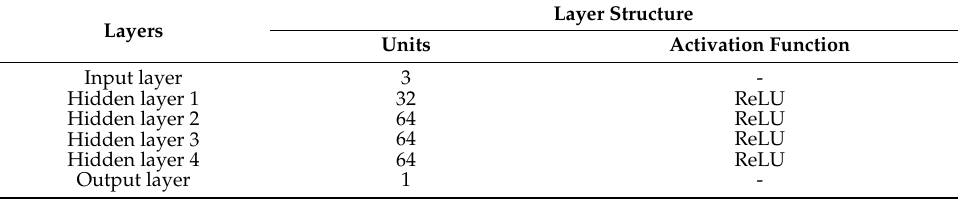
Table 7. The structure of critic network Q ( s , a ; θ Q ) .